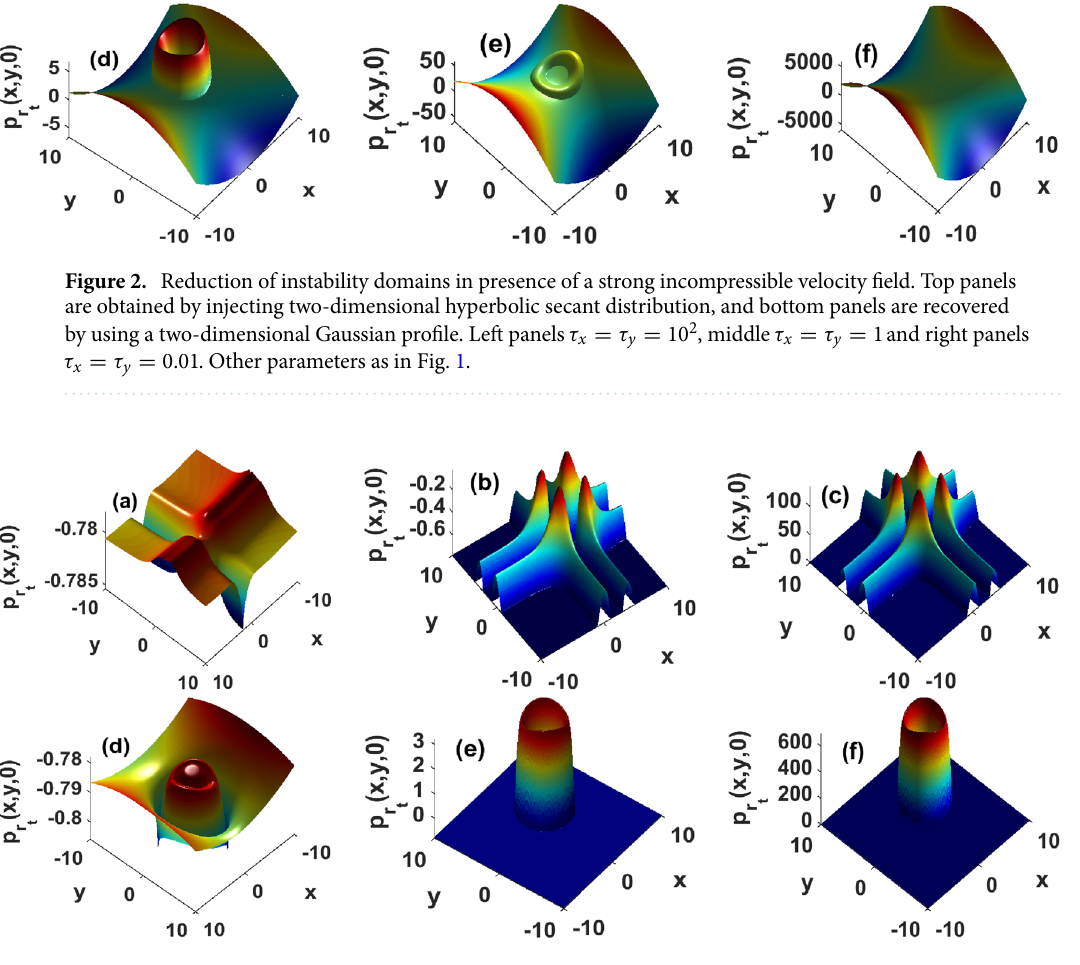
Figure 3. Spreading of unstable domains with surface tension, and for weak incompressible flows τ x = τ y = 10 2 . Top panels are obtained by injecting the hyperbolic secant distribution, and bottom panels are derived using a Gaussian profile. Left panels D 2 = 1.62 · 10 − 3 , middle D 2 = 1.62 and right panels D 2 = 162 . Other parameters as in Fig.